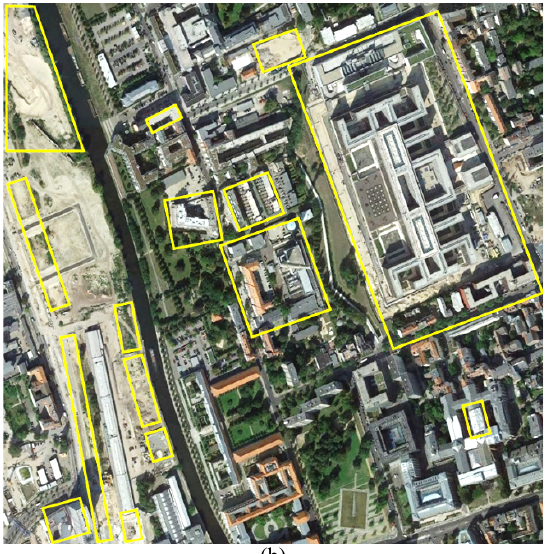
Figure 5. Study area at the north of Berlin central station. (a) Mean TerraSAR-X image. (b) Aerial image (Google Earth) acquired on September 5, 2014. Yellow square, building construction.